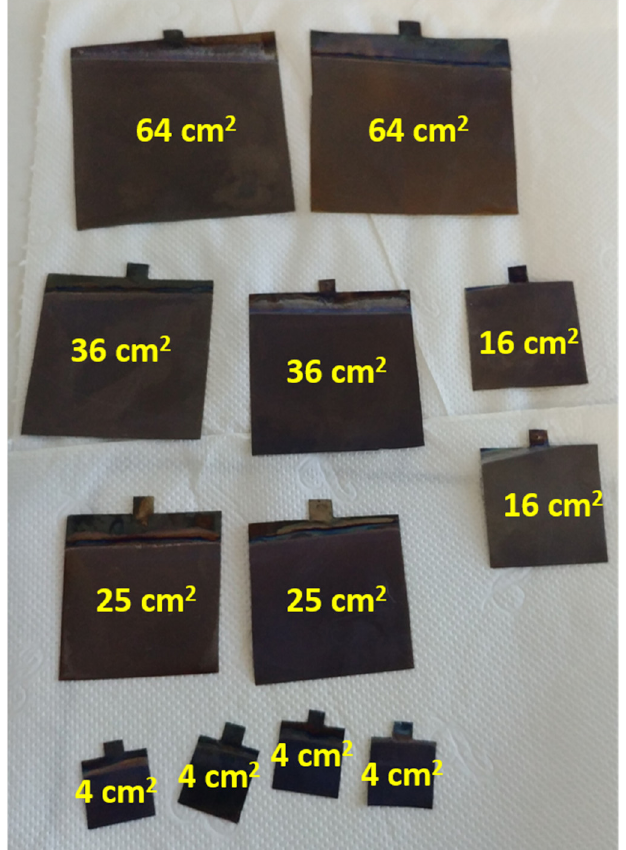
Figure 1. Titanium foil (of different dimensions) after the anodization and calcination process.